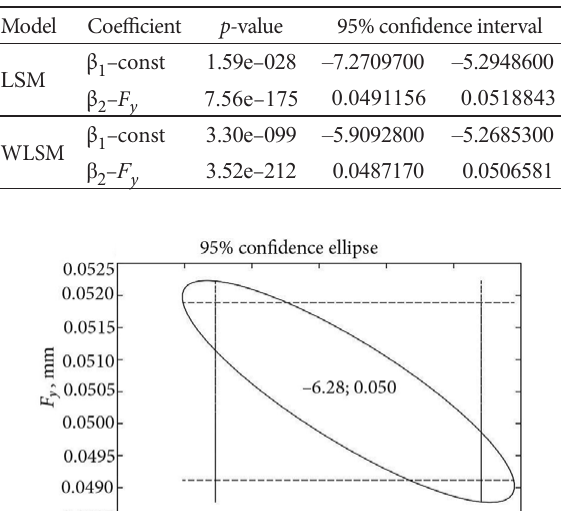
Table 6. Confidence intervals of the parameters for the LSM